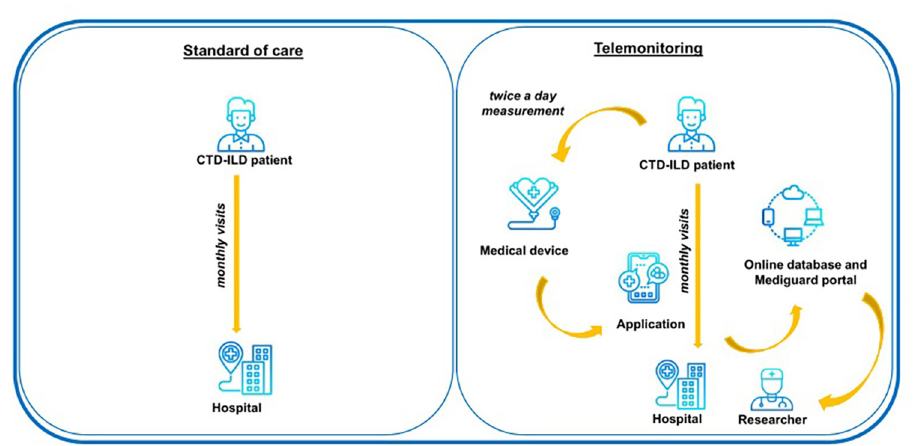
Fig 3. TEL-CTD-ILD study